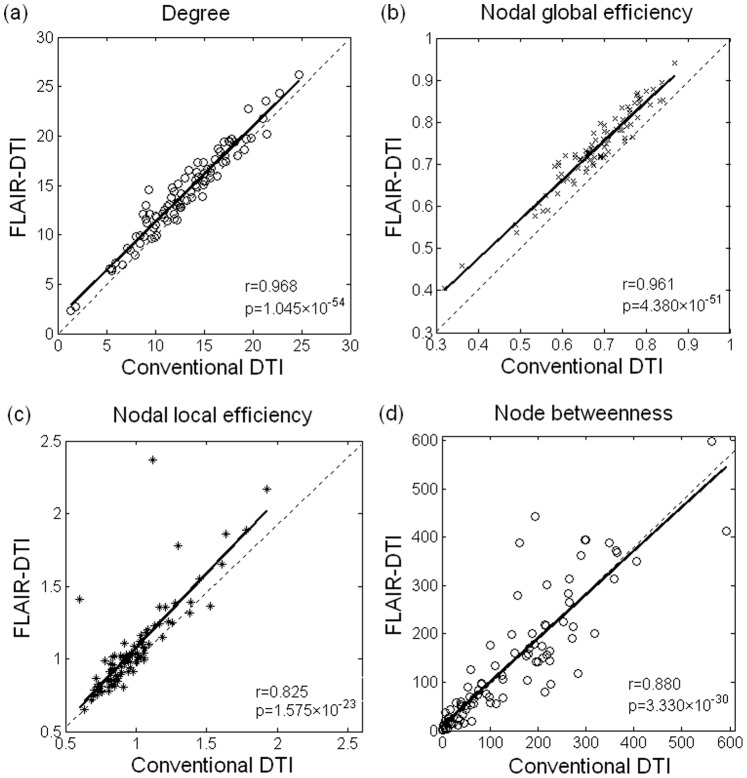
Variation in the nodal parameters derived from the conventional DTI and FLAIR-DTI datasets.The solid line represents the result of linear fitting. The ○, ×, *, and ◊ symbols in (a), (b), (c), and (d) represent the 90 brain regions from the AAL template. Three outliers in (c) correspond to HES.L, HES.R and PAL.L. Four outliers in (d) correspond to CAL.L, LING.L, PCUN.R and MTG.R.